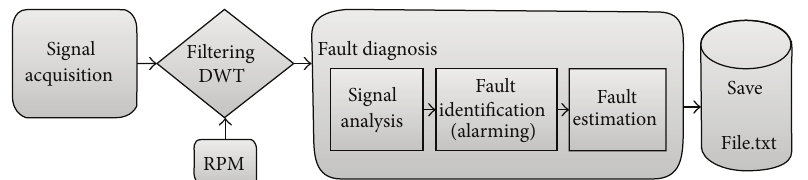
Figure 12: Scheme of failure diagnosis system.